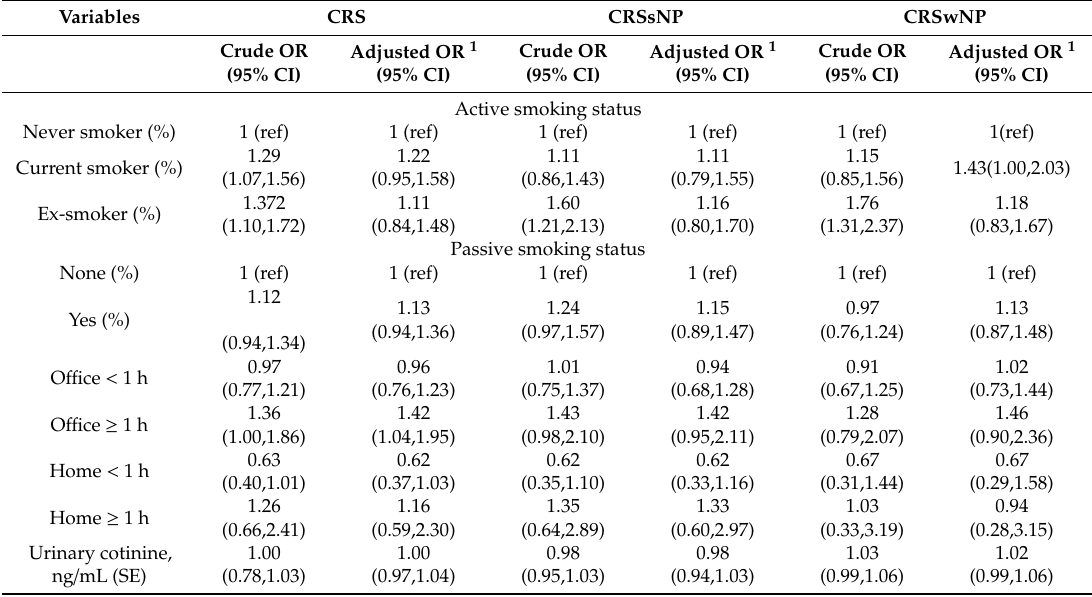
Table 2. Association between the self-response cigarette exposure status and chronic sinusitis in KNHANES V